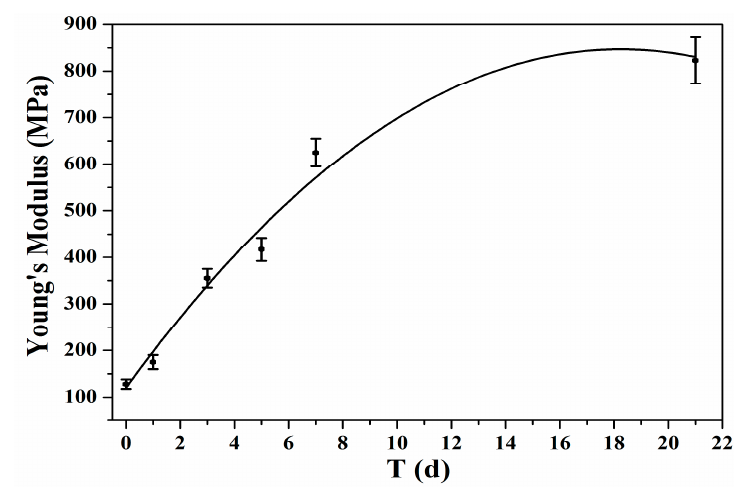
Figure 6. Young’s Modulus figure of PLA nanofibers with different mineralization times.